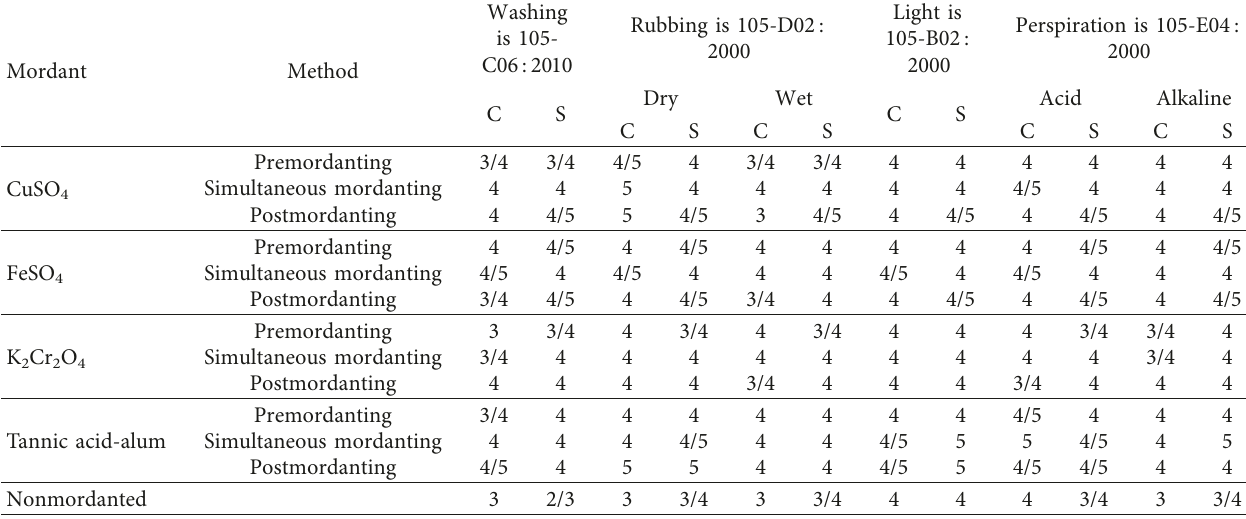
Table 5: Colour fastness rating to colour change and